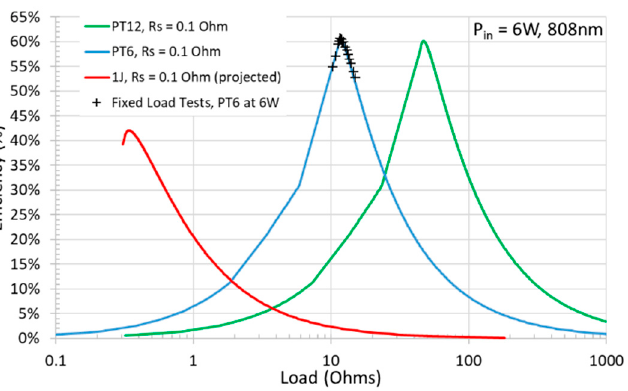
Figure 7. Performance vs. output load resistance for medium-power OPCs for P in = 6 W (average optical intensity of 41.6 W/cm 2 ) for a PT12, a PT6, and a single junction device. Solid lines from I-V curves and crosses are from fixed-load